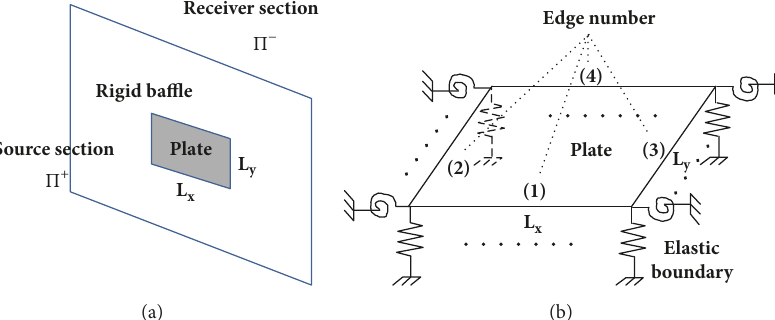
Figure 1: Schematic illustration of a baffled rectangular plate structure: (a) a plate mounted on an infinite rigid baffle; (b) elastic boundary supports along the